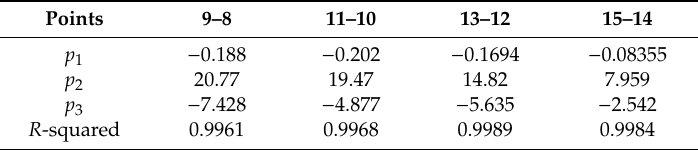
Table 4. Pressure di ff erence and flow angle coe ffi cient and parameters.